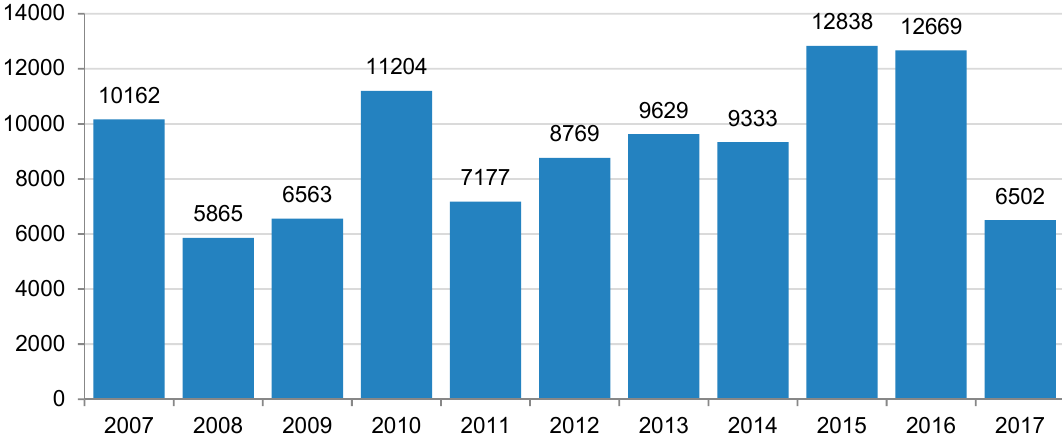
Figure 2. Number of scientific data takes of the TerraSAR-X mission between 19 June 2007 and 30 June 2017.